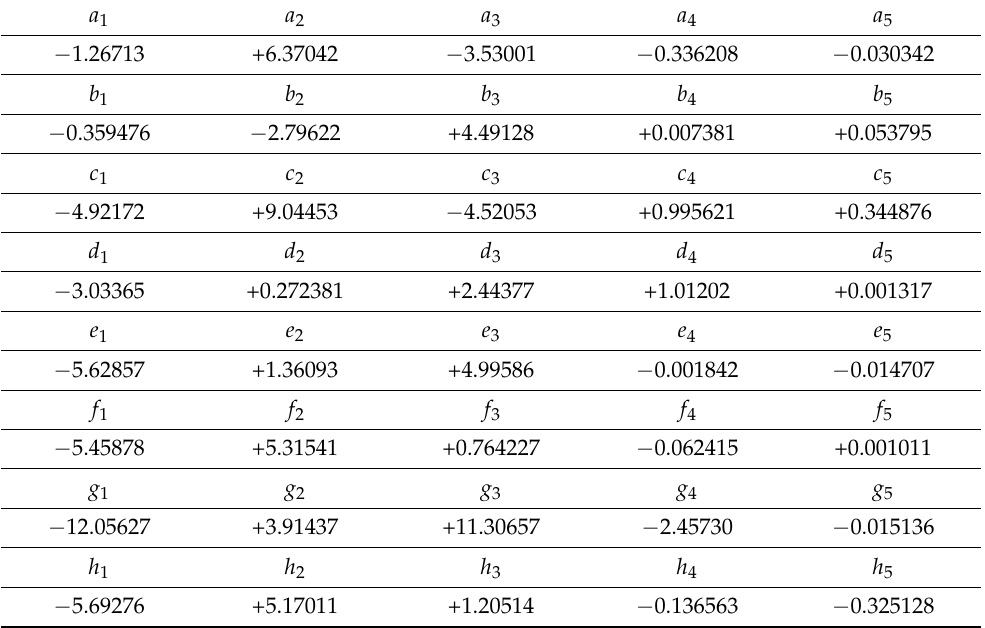
Table 5. Heat pump model